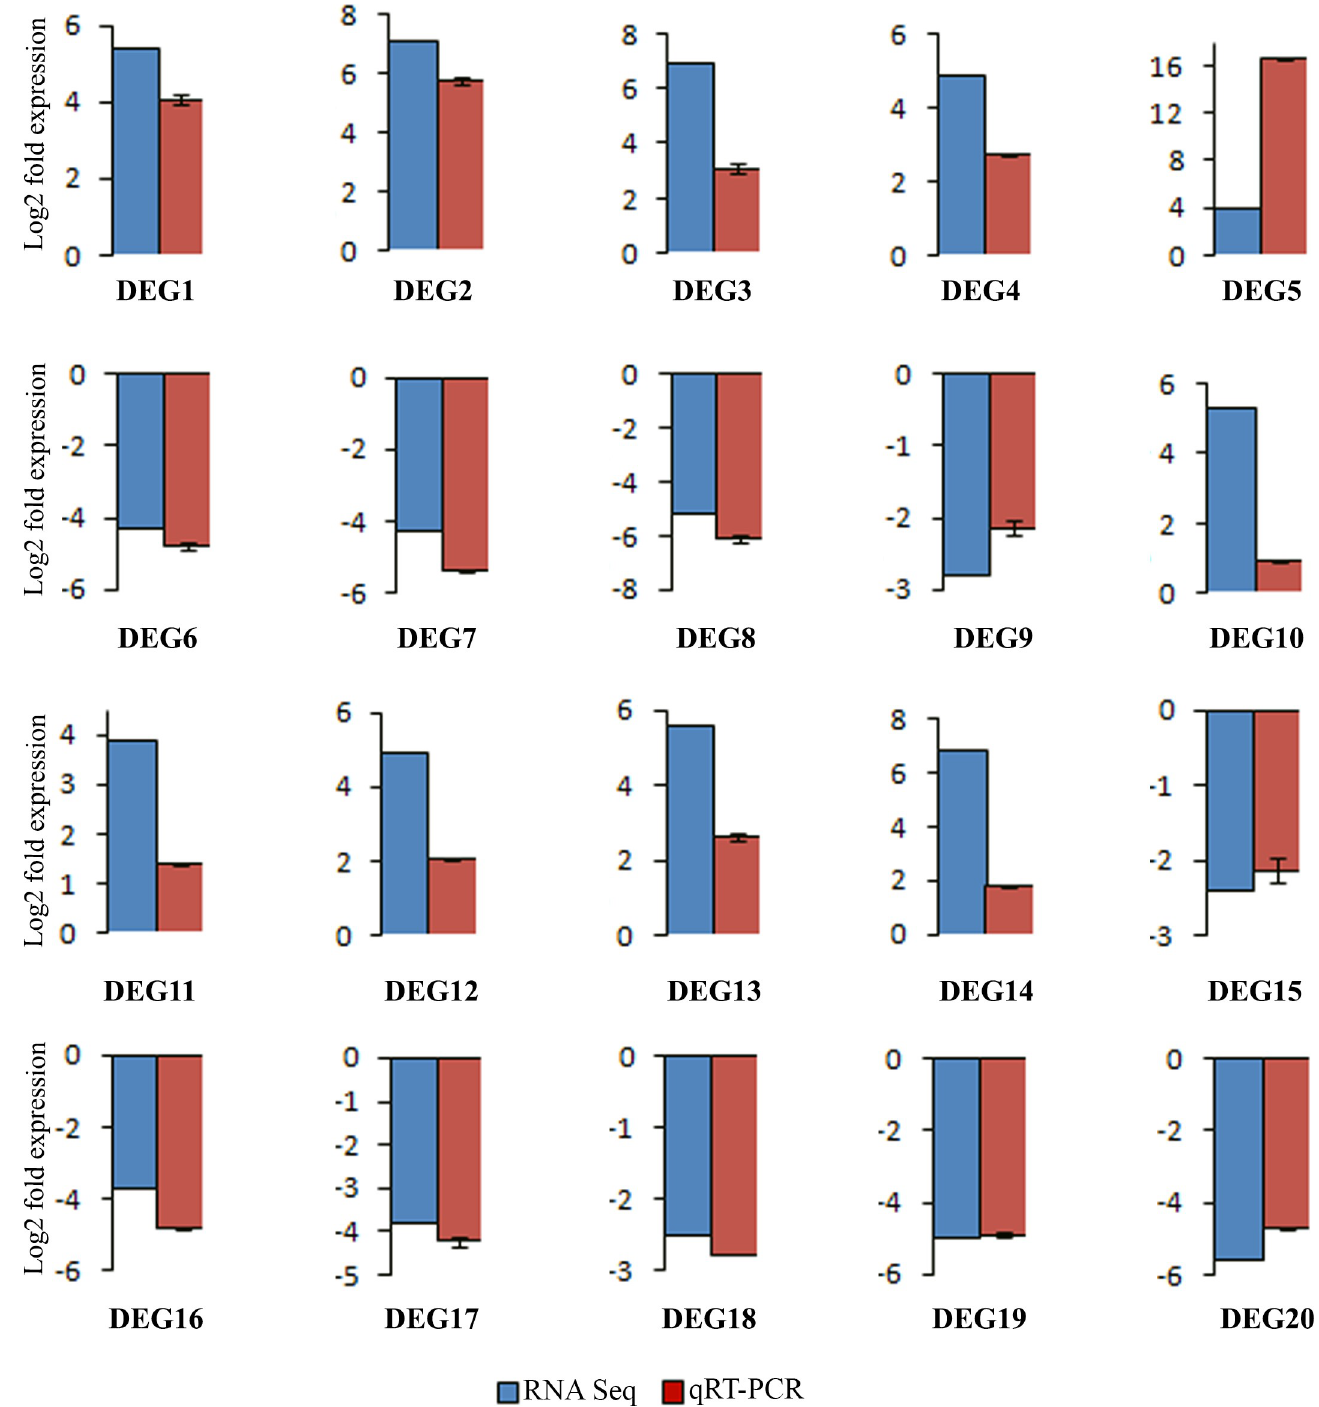
Fig 8. Validation and comparison of the RNA-seq and qRT- PCR expression profile of differentially expressed genes [Cysteine- rich receptor- like protein 3 (DEG1); G-type lectin receptor-like serine/threonine protein kinase (DEG2); Receptor-like protein kinase FERONIA (DEG3); Wall-associated receptor kinase-like 14 (DEG4); LysM domain receptor-like kinase 3 (DEG5); L-type lectin-domain containing receptor kinase VIII.2-like (DEG6); Transcription factor PIF3-like (DEG7); Heat stress transcription factor A-6b-like (DEG8); Protein LHY isoform X3 (DEG9); Transcription factor bHLH48-like (DEG10); calmodulin-binding transcription activator 1-like isoform X2 (DEG11); Probable WRKY transcription factor 41 (DEG12); probable methyltransferase 19 (DEG13); Subtilisin-like protease SBT1.6 (DEG14); U-box domain-containing protein 4 (DEG15); Zeatin expoxidase (DEG16); Delta-1-pyrroline-5-carboxylate synthase-like isoform X2 (DEG17); Flavonol synthase/flavanone 3-hydroxylase (DEG18); Probable inositol transporter 2 isoform X2 (DEG19); B-box zinc finger protein 18-like (DEG20)].